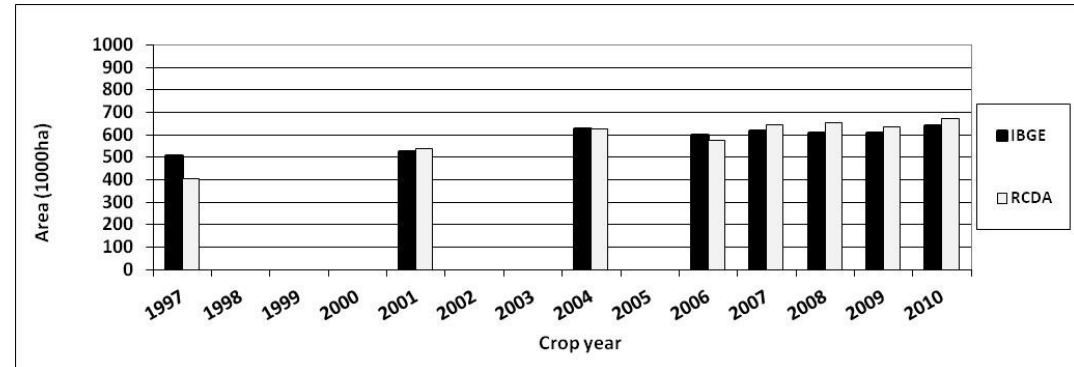
Figure 7. Comparison between RCDA and IBGE soybean area estimates for the entire study